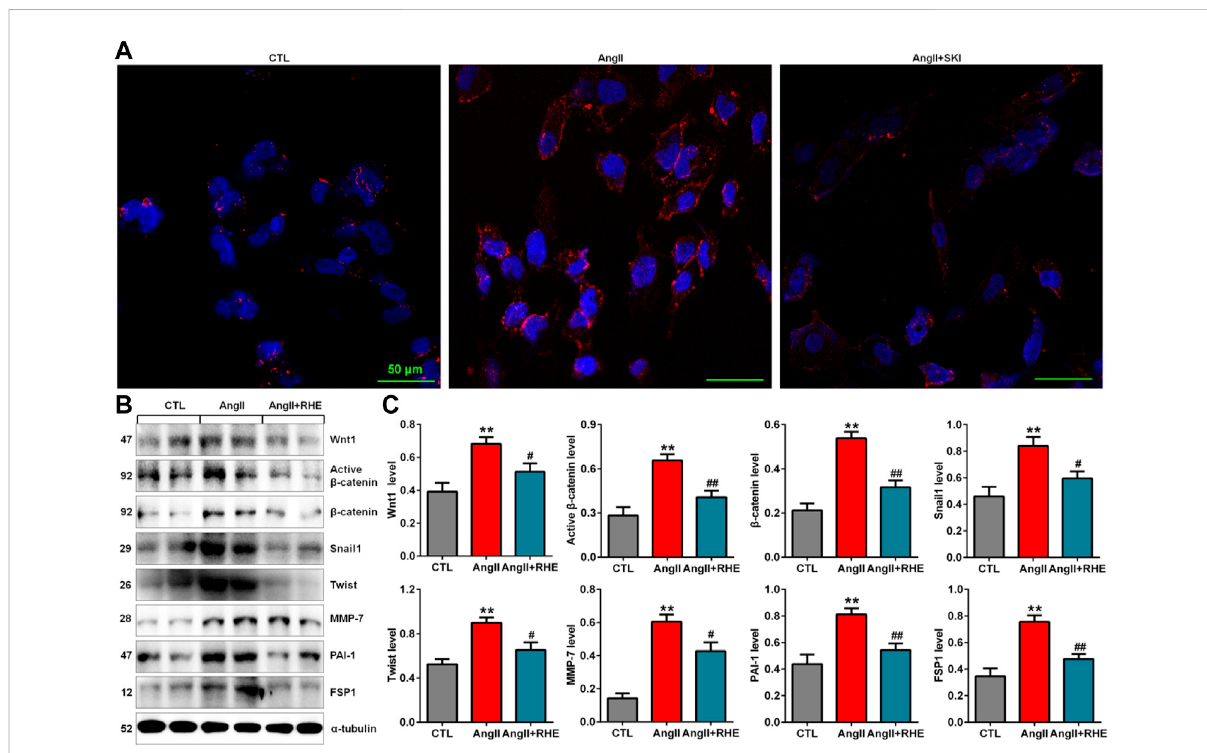
FIGURE 7 Rhein inhibited the Wnt/ β -catenin signalling pathway in AngII-induced HK-2 cells. (A) Representative immuno fl uorescent analysis of β -catenin in AngII-induced HK-2 cells treated with rhein. (B) Protein expression of Wnt1, active β -catenin and β -catenin, as well as its downstream target gene products, including Snail1, Twist, MMP-7, PAI-1, and FSP1, in AngII-induced HK-2 cells treated with rhein. (C) Quantitative analysis of the protein expression of Wnt/ β -catenin signalling pathway factors in AngII-induced HK-2 cells treated with rhein. ** p < 0.01 compared with the control group; # p < 0.05, ## p < 0.01 compared with the AngII-induced